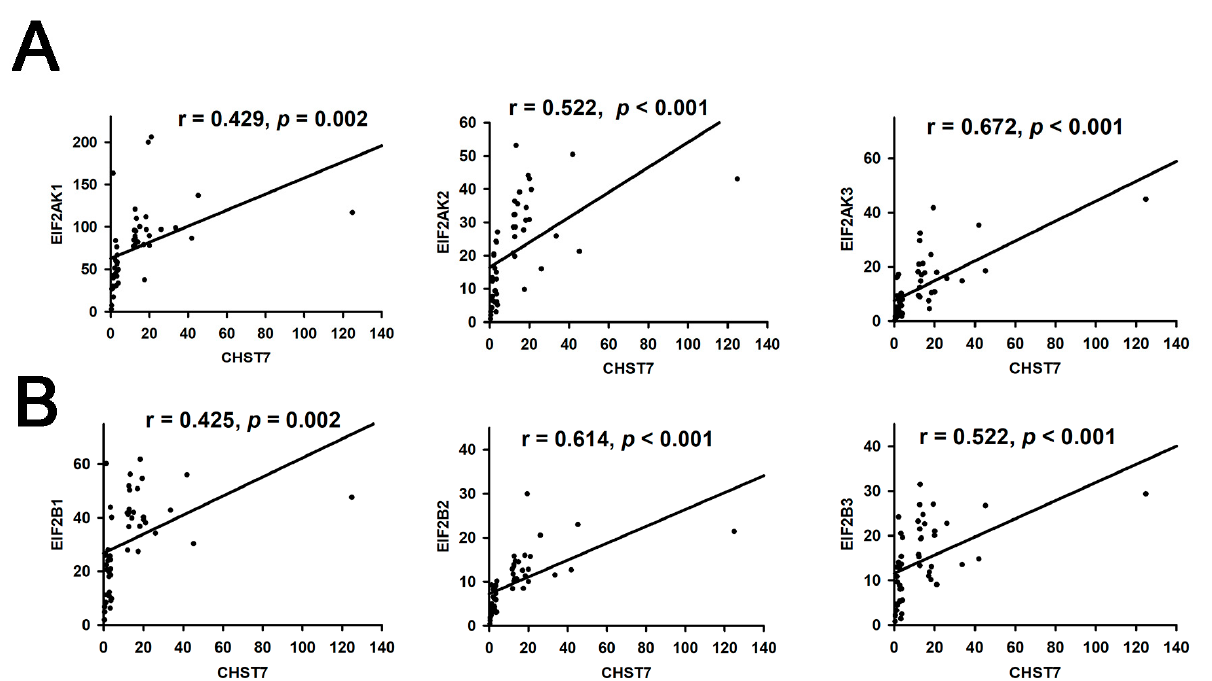
Figure 2. Correlation analysis of CHST7 and EIF2 pathway. ( A ) Correlation of CHST7 and EIF2AK1-3. ( B ) Correlation of CHSTY and EIF2B1-3.